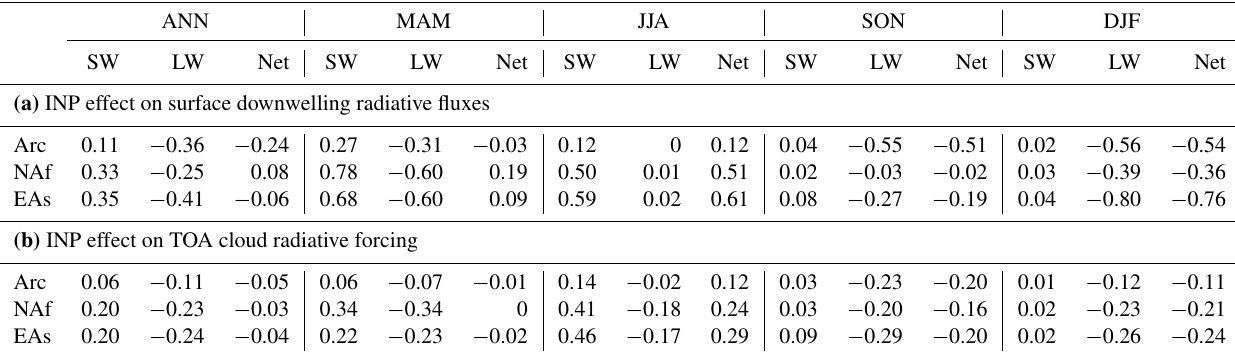
Table 4. Arctic (60–90 ◦ N) averaged surface downwelling radiative fluxes and TOA cloud radiative forcing changes caused by dust INPs originating from local Arctic sources (Arc), North Africa (NAf), and East Asia (EAs) (Wm − 2